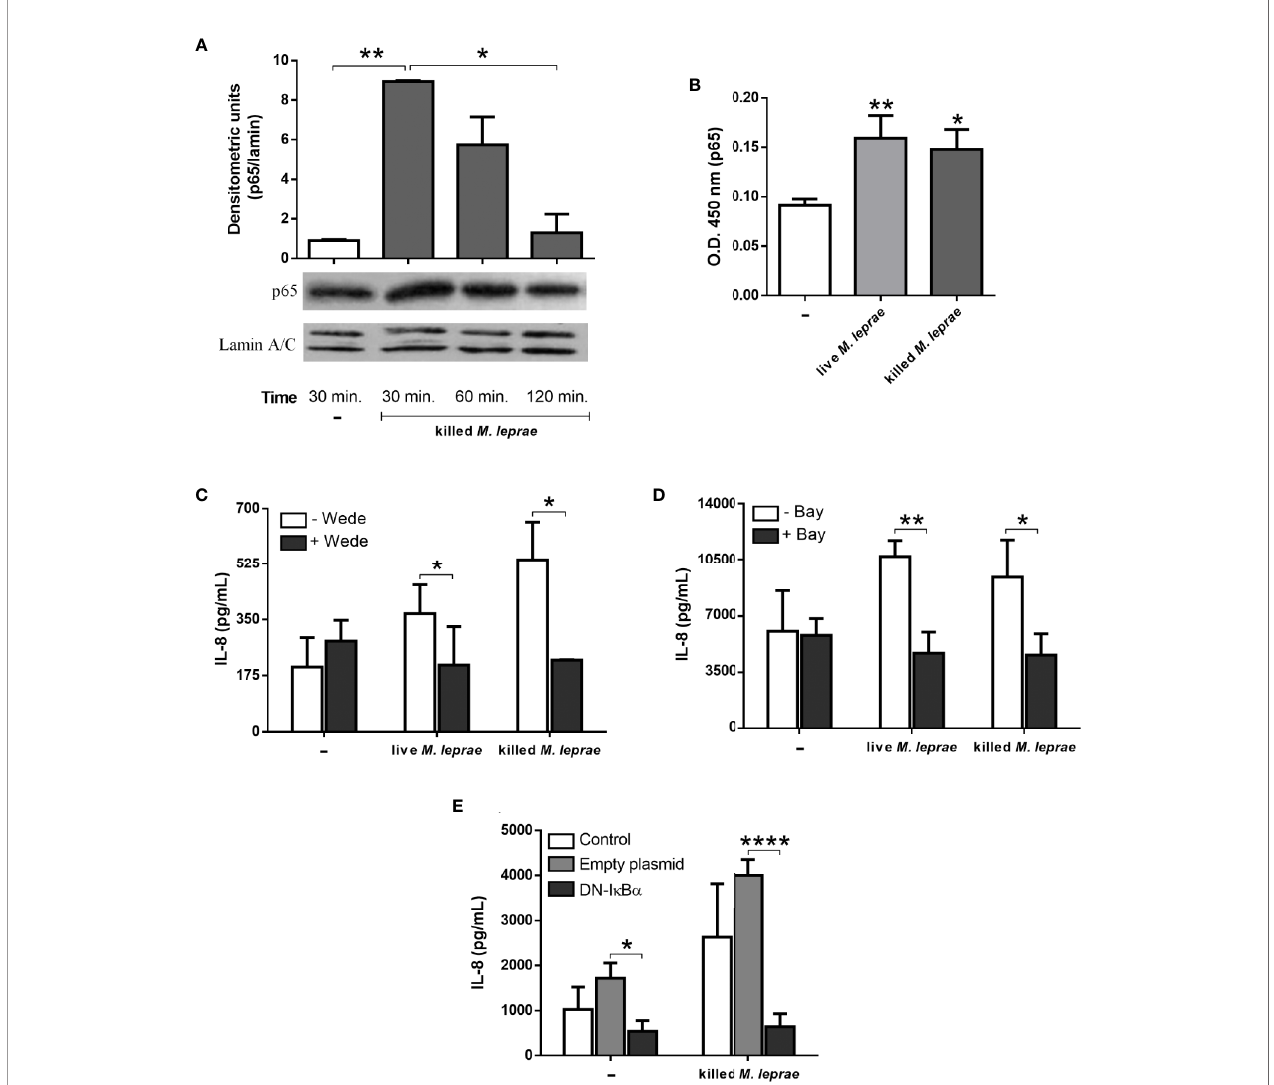
FIGURE 3 | M. leprae induces activation of the NF- k B transcription factor in human alveolar epithelial cells. The relative levels of p65 in the nuclear extract of A549 cells were measured by immunoblotting (A) and by ELISA (B) . For immunoblotting assays, the cells were stimulated with killed M. leprae at a bacterium:cell ratio of 50 for 30, 60, and 120 minutes while for ELISA the cells were stimulated with live or killed M. leprae at bacterium:cell ratio of 50 for 30 minutes. Normalization was performed with lamin A/C and the densitometric units were arbitrary. Immunoblotting image shown as representative of 3 independent experiments performed in duplicate. (C, D) ELISA quanti fi cation of IL-8 levels in culture supernatants of A549 cells pretreated with wedelolactone (C) or Bay11-7082 (D) followed by stimulation with live or killed M. leprae at a bacterium:cell ratio of 50 for 24 hours. (E) ELISA quanti fi cation of IL-8 levels in culture supernatants of A549 cells transfected with DN-I k B a and stimulated with killed M. leprae at a bacterium:cell ratio of 50 for 24 hours. (A – E) Unpaired t -test with differences considered statistically signi fi cant between them (A, C – E) or in relation to the untreated cells (B) . *p < 0.05; **p < 0.01; ****p < 0.0001. Values represent the mean ± standard deviation of at least 3 independent experiments performed in